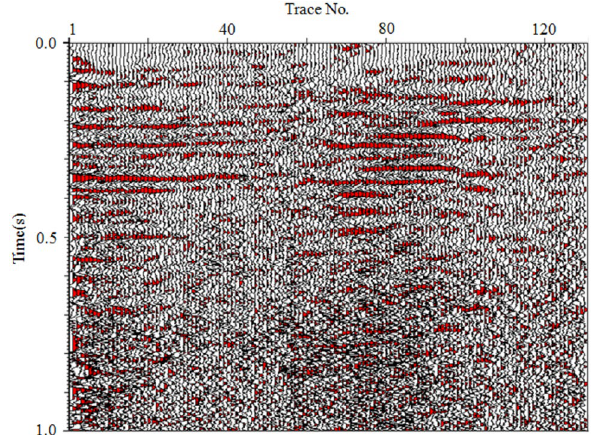
Fig. 4 A stacked section contaminated with random interference noise. The deep reflection is concealed by the strong background noise Fig. 5 Frequency spectra of the raw and filtered seismogram (trace